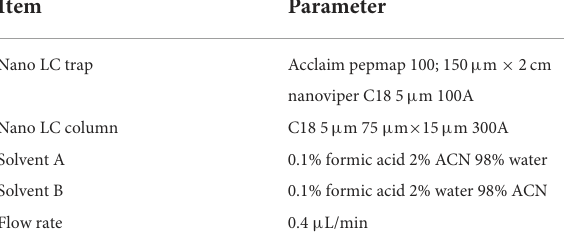
TABLE 2 The parameter of Dionex ultimate 3,000 nano LC